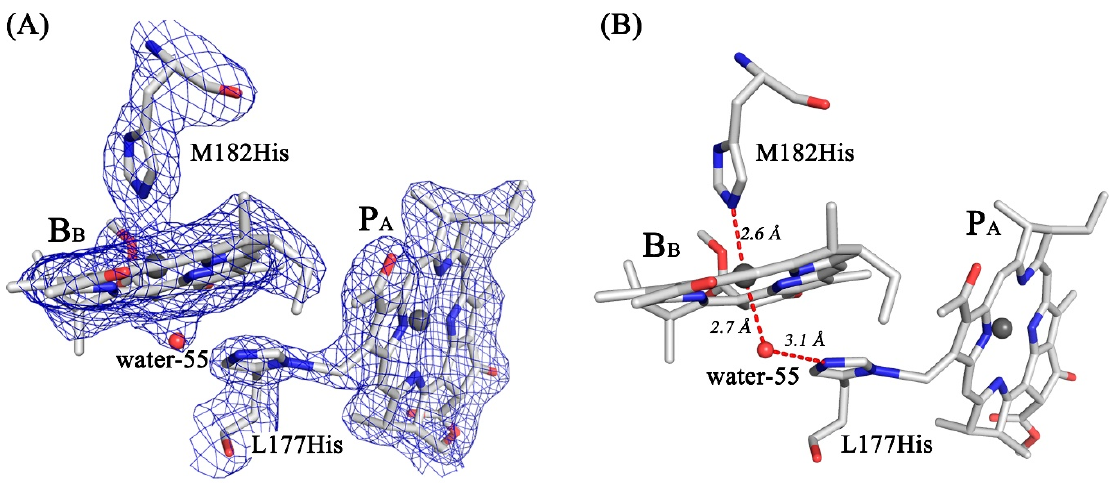
Figure 4. Electron density maps for RC I(L177)H + F(M197)H attributable to the P A and B B BChls as well as the His-L177 residue ( A ) and the structural model fitted to the density ( B ) (PDB ID: 8C3F). The imidazole group of His-L177 points towards the methyl carbon of the pyrrole ring I of P A with the center-to-center distance between N and C atoms of 2.06 Å. According to the electron density map, imidazole forms a covalent bond with the methyl carbon of P A with a high degree of probability. Based on the structural data, we modeled pigment-protein interactions that occur as a result of Ile → His substitution at the L177 site (Figure 4B). Comparison of the structures of the double mutant RC and RC F(M197)H in the proximity of BChl P B shows structural conservation in the main body of the protein as well as in the cofactor system. In both complexes, the imidazole group of His-M197 is located within the H-bond distance from the C2-acetyl carbonyl group of BChl P B . It was noted that the C2-acetyl group shows 29.7 ◦ out of plane rotation (Figure 5), which is more significant compared with that observed in RC F(M197)H (20.7 ◦ ) [10]. The data are consistent with spectral properties of RC I(L177)H + F(M197)H (as discussed below).